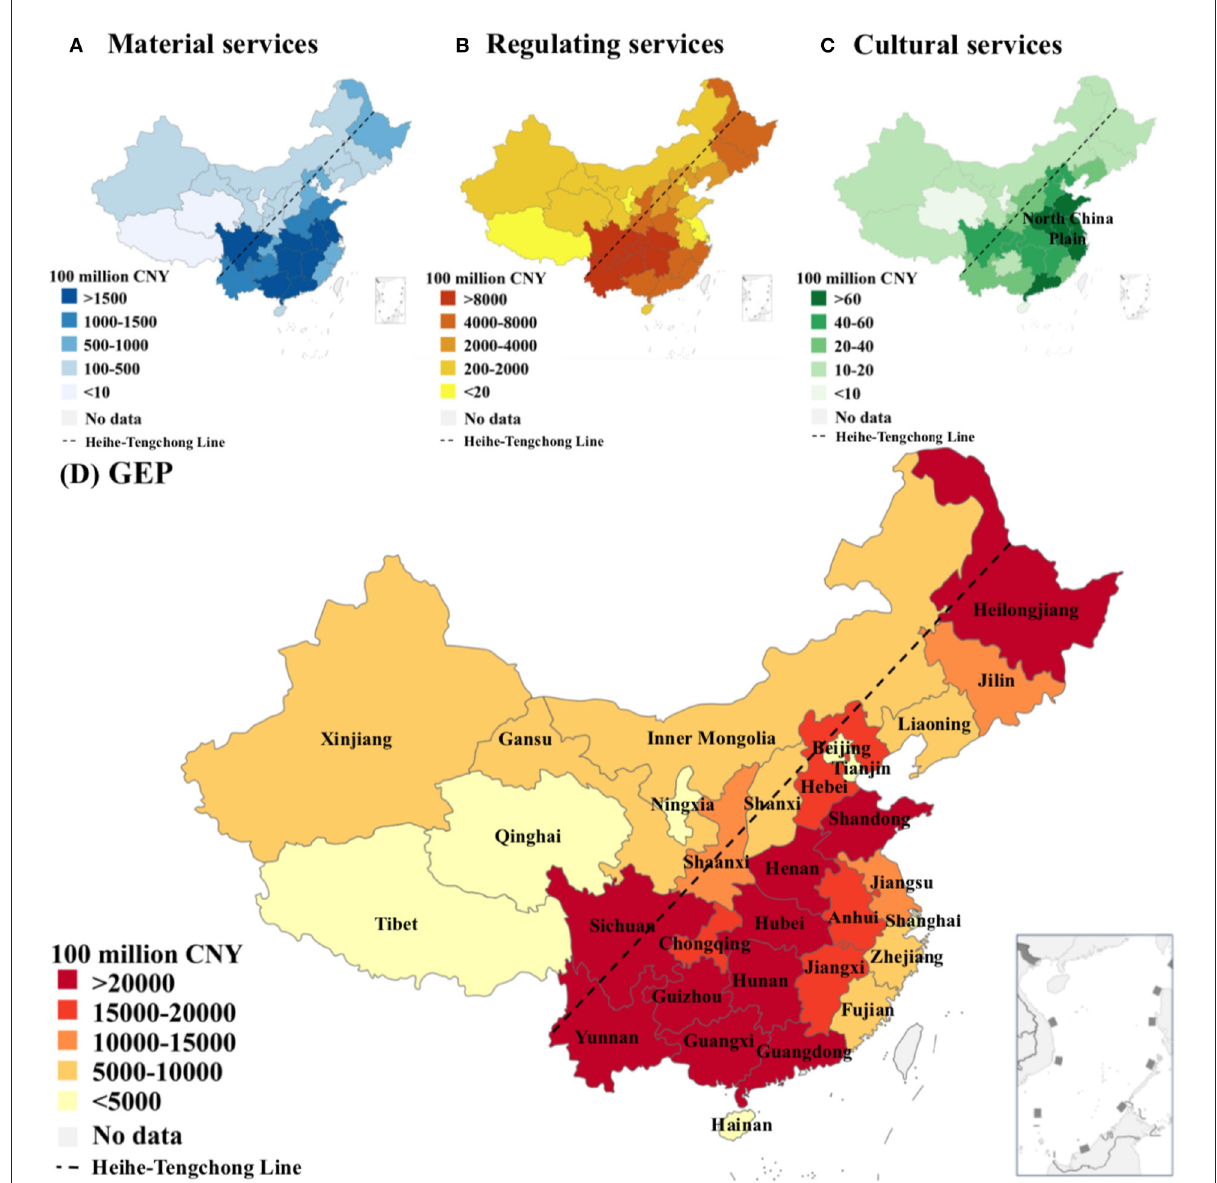
FIGURE1 Spatial patterns of cropland ecosystem services in China during 2001–2019. (A – C) Spatial patterns of the multiyear mean values of the material, regulating, and cultural services; (D) Spatial pattern of the multiyear mean value of gross ecosystem product (GEP). The dashed line indicates the Heihe-Tengchong